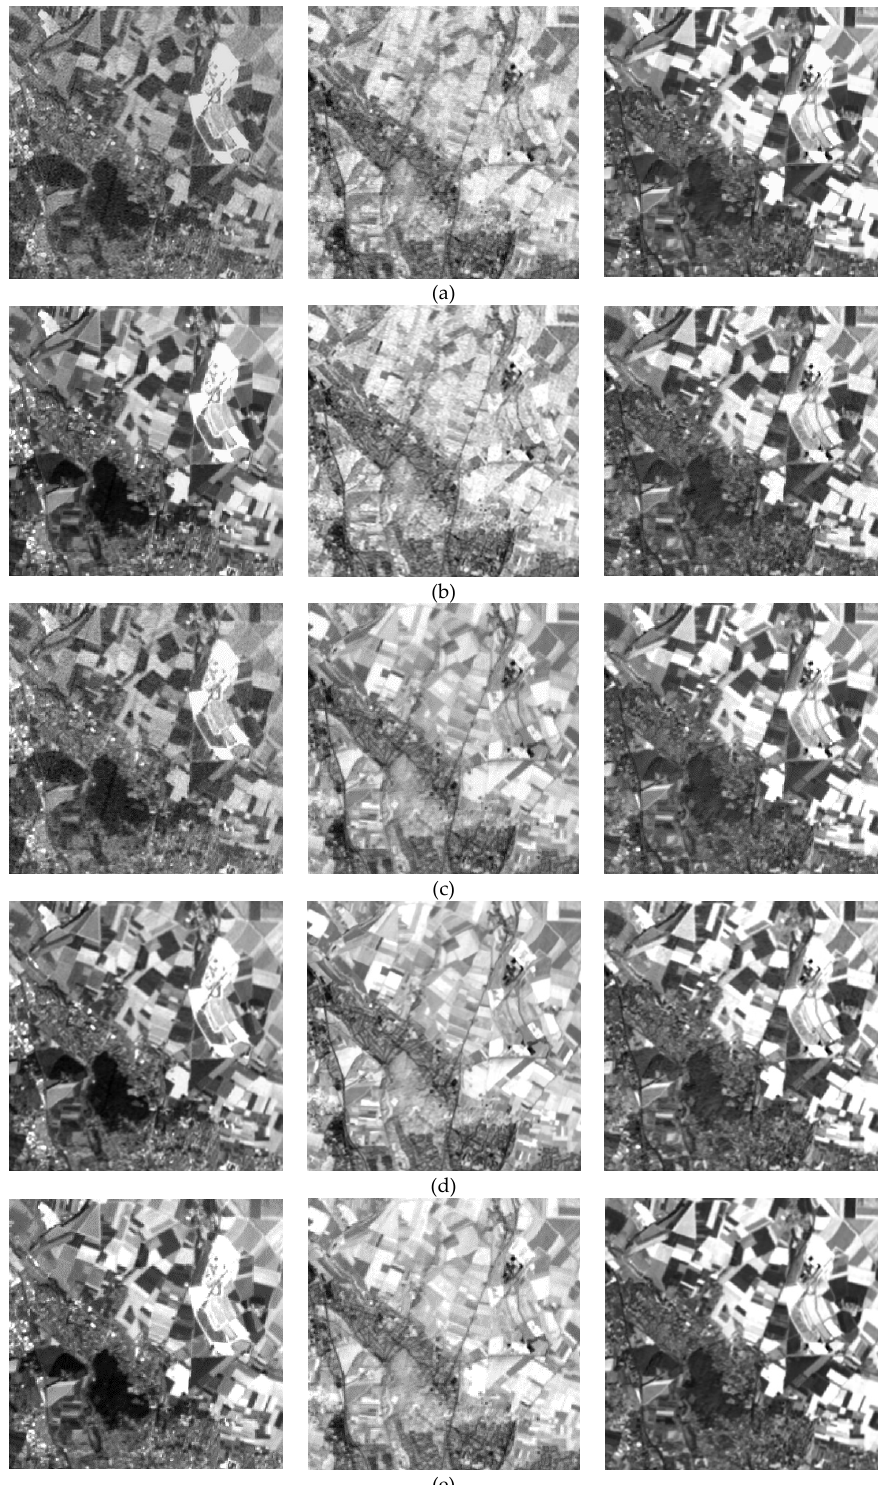
Figure 11. Comparison of sub-scenes in real dataset at band 550nm, band 900 nm, and band 1600 nm (from left to right) ( a ) Indusion + Arad method, ( b ) Indusion + SREM method, ( c ) SparseFI + Arad method, ( d ) SparseFI + SREM method, ( e ) our proposed J-SpeSpaRE